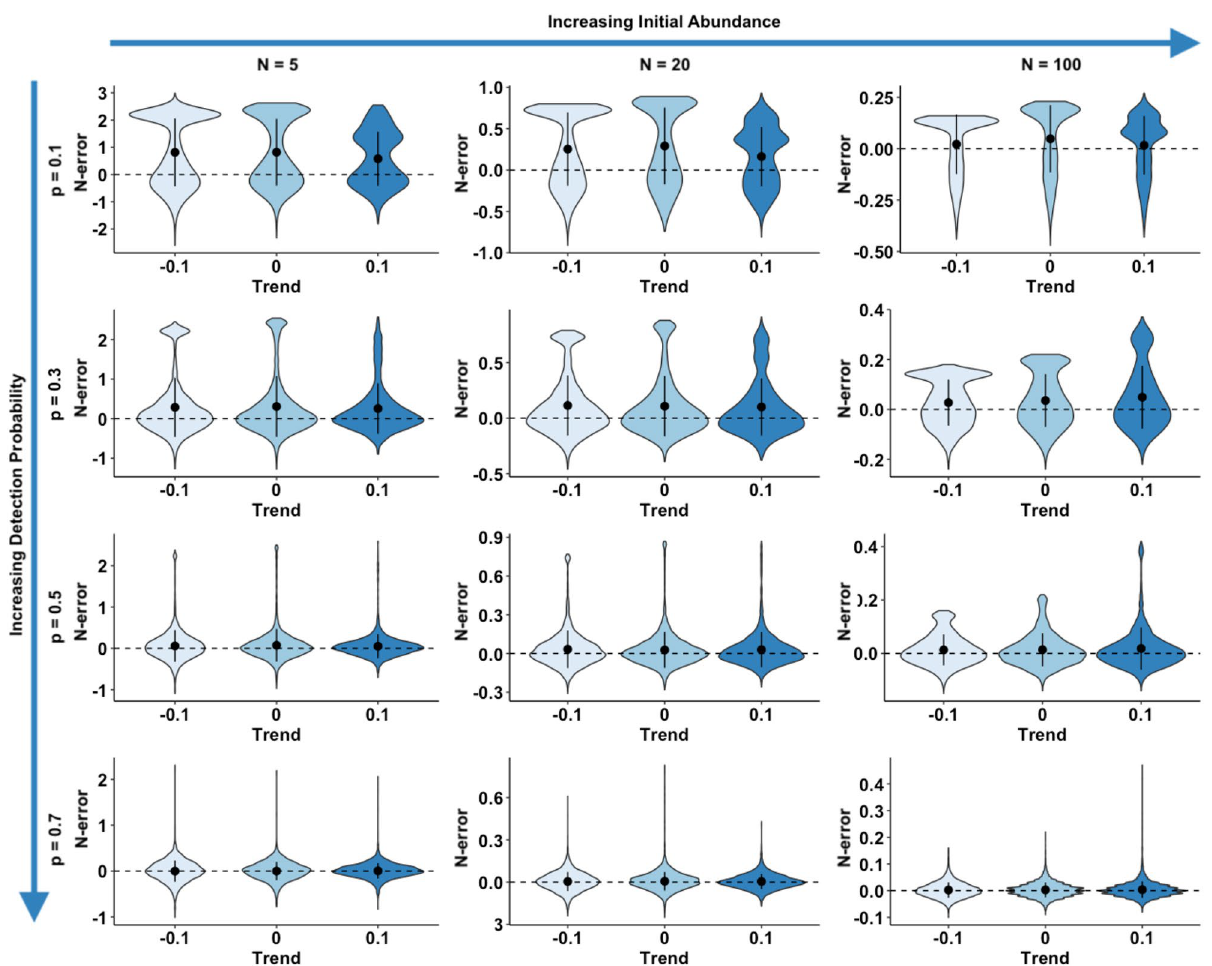
Figure 2. Violin plots of the observed error in abundance estimation (N-error) for several scenarios, according to different levels of initial abundance, detection probability, and population trend. Black dots and vertical bars inside each violin plot represent the mean and standard deviation,